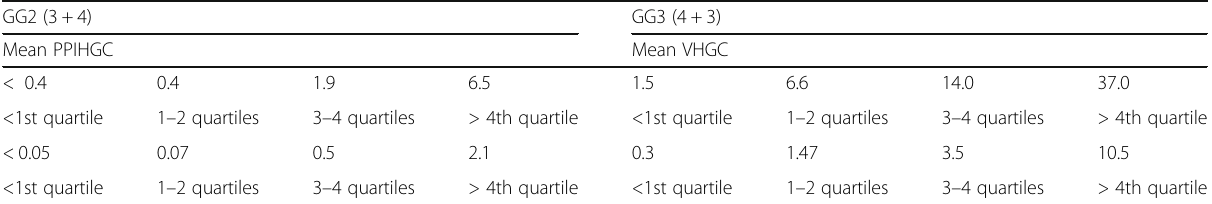
Table 1 Distribution of mean percentage of the prostate involved by high grade carcinoma (PPIHGC) and volume of high grade carcinoma (VHGC) values among different quartiles of distribution of GG2 and GG3 tumors 159 radical prostatectomy specimens (see reference (Souza et al.